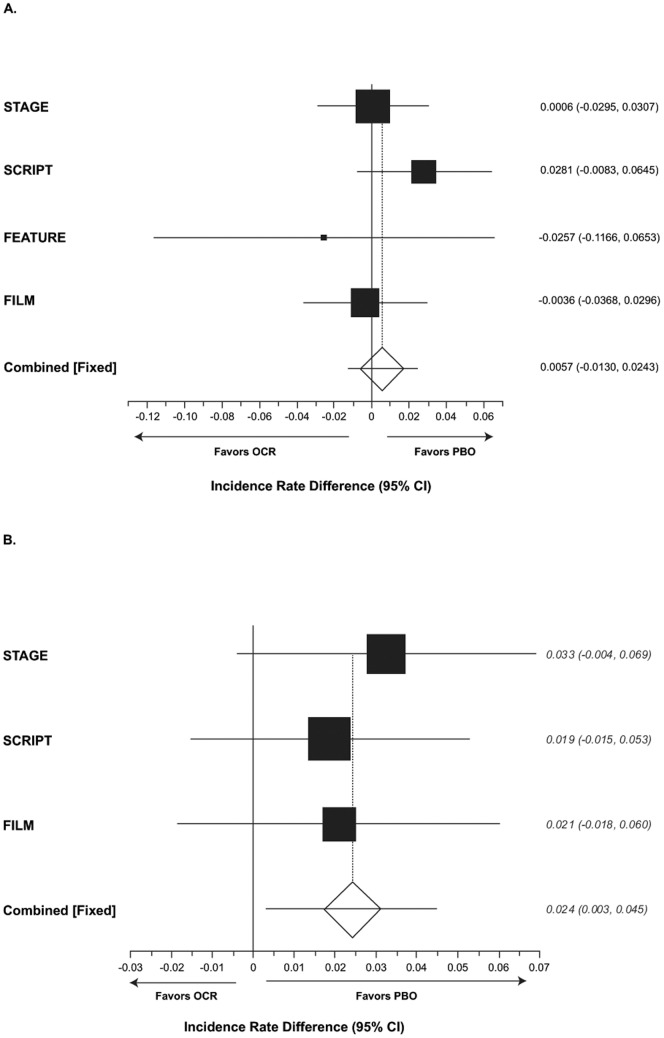
Fixed-effects meta-analysis of incidence rate differences in serious infectious events (SIEs).(A) OCR200+MTX; (B) OCR500+MTX. The pooled rate difference accounts for study and is weighted according to the inverse of the estimated variance. These analyses are based on patients with at least one event (does not count all events). Zero indicates no difference, and a positive value indicates that ocrelizumab (OCR) is worse. MTX, methotrexate; OCR200, ocrelizumab 200 mg×2; OCR500, ocrelizumab 500 mg×2; PBO, placebo.